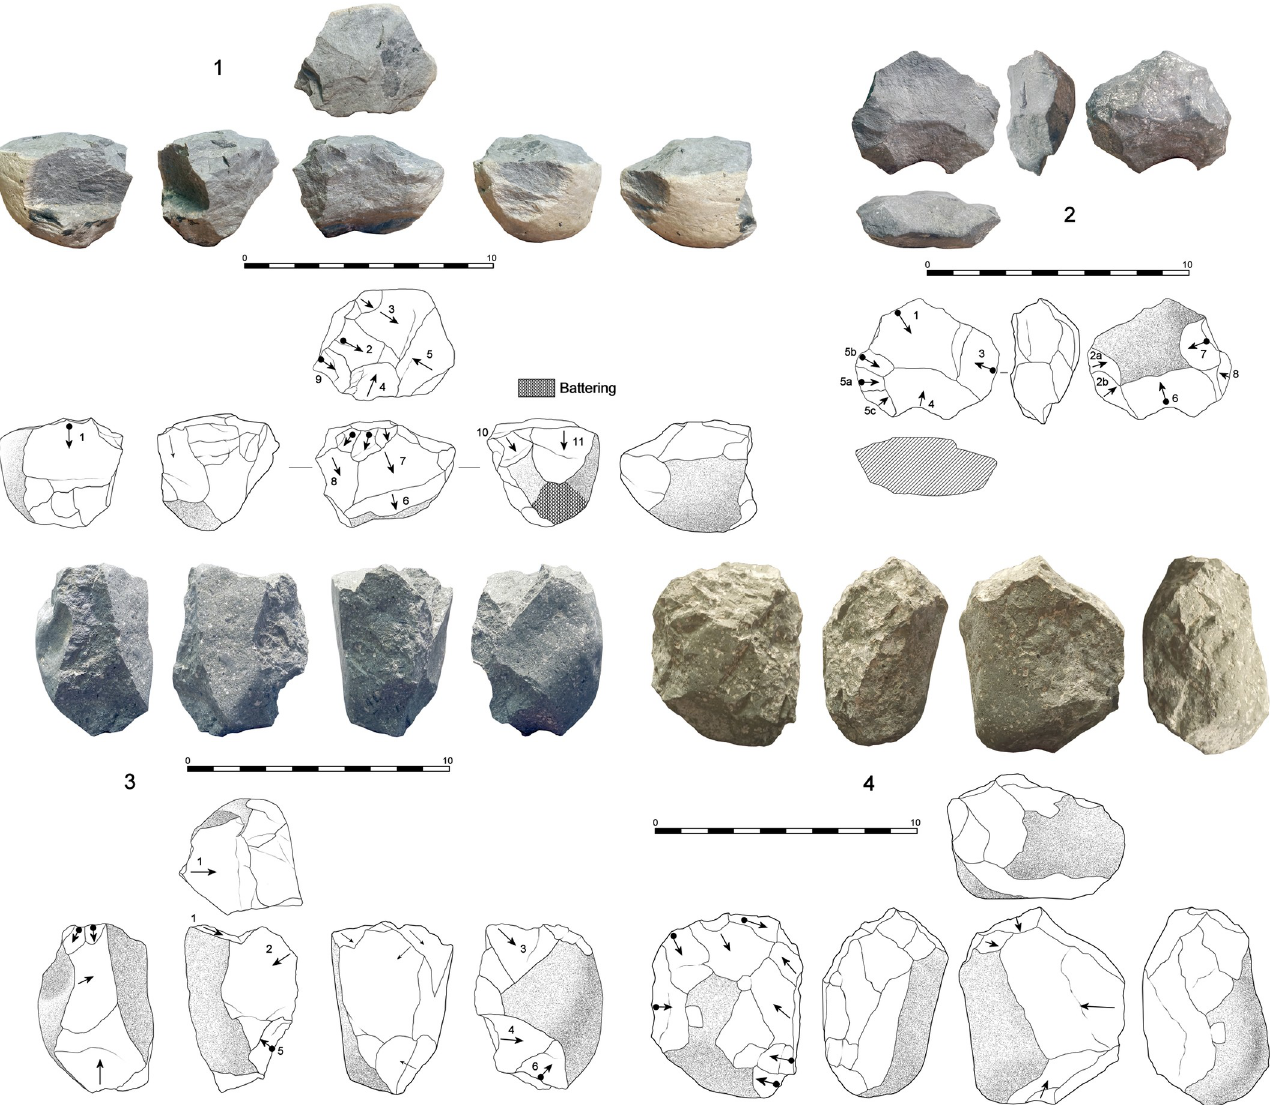
Fig 5. Cores from DS. 1. Bifacial orthogonal (BO) small core on basalt (53x41x39 mm, 123 g). The upper surface shows a series of removals with an orthogonal arrangement, while the thickness plane of the pebble has also been exploited. No hierarchy exists between the surfaces. Negatives with step termination can be observed. Intense signs of percussion have been observed at the globular base; 2. Bifacial centripetal (BC) small core on basalt, with no signs of hierarchization of surfaces. Upper face shows a centripetal arrangement of negatives and the specimen is in its exhaustion stage (56x43x23 mm, 66 g); 3. Bifacial alternating (BA) core on phonolite, showing an alternating sequence of scars detached from the same plane (60x52x42 mm, 176 g); 4. Bifacial orthogonal (BO) core on phonolite. One surface shows a bifacial arrangement of negatives. Step terminations are frequent and areas with percussion damage can also be observed (72x58x41 mm, 228